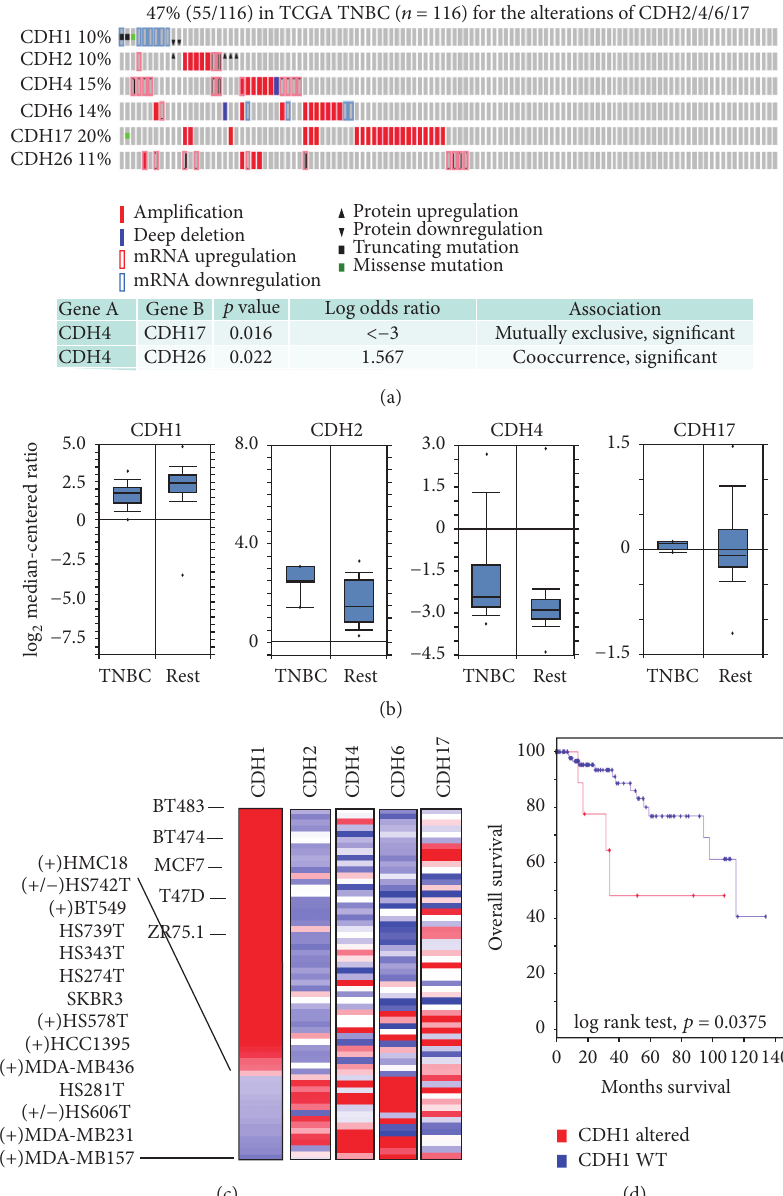
Figure 1: Alterations of CDHs in triple-negative breast cancer. (a) Alterations of CDH1, 2, 4, 6, 17, and 26 in TNBC samples from TCGA provisional datasets. The alterations here include deletion, amplification, downregulation, upregulation, and mutations. CDH1 was queried withEXP < −2.0 MUTHOMDELPROT < −2.0 andotherCDHswerequeriedwithdefaultparameters.MicroarraydatawereusedformRNA expression level. The data were retrieved from cBioPortal as of December 15, 2016 (TNBC samples, 𝑛 = 116 ). CDH, cadherin; TNBC, triple- negative breast cancer; TCGA, The Cancer Genome Atlas. EXP, mRNA expression level; MUT, mutation; HOMDEL, homozygous deletion; PROT, protein level as determined by reverse phase protein assay (RPPA). (b) Expression of CDH1, 2, 4, and 17 in TNBC compared to non- TNBC samples. These data were retrieved as of December 15, 2016, from Oncomine. Rest indicates non-TNBC samples. For CDH1 (from partial TCGA dataset), TNBC, 𝑛 = 46 ; rest, 𝑛 = 250 . For CDH2 (from Curtis breast dataset, European Genome-phenome Archive accession number EGAS00000000083), TNBC, 𝑛 = 4 ; rest, 𝑛 = 17 . For CDH4 (from partial TCGA dataset), TNBC, 𝑛 = 49 ; rest, 𝑛 = 300 . For CDH17